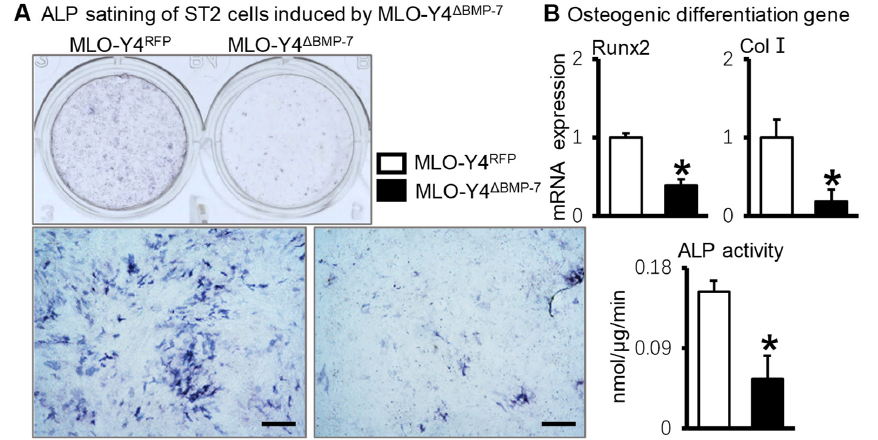
Figure 6. The osteogenic differentiation of ST2 cells when cocultured with BMP-7-silenced MLO-Y4 cells. ( A ). ALP staining and quantitative analysis of ALP activity in the coculture system of BMP-7- silenced MLO-Y4 cells and ST2 cells. ( B ). The osteogenic gene expression in the coculture system of BMP-7-silenced MLO-Y4 cells and ST2 cells. * p < 0.05, compared with MLO-Y4 RFP group. Scale bar: 50 µ